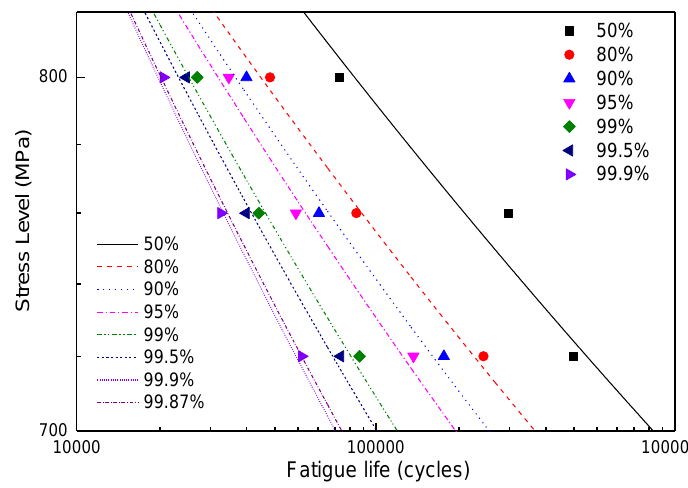
Figure 8. Fatigue lives under typical reliabilities based on a BLG.